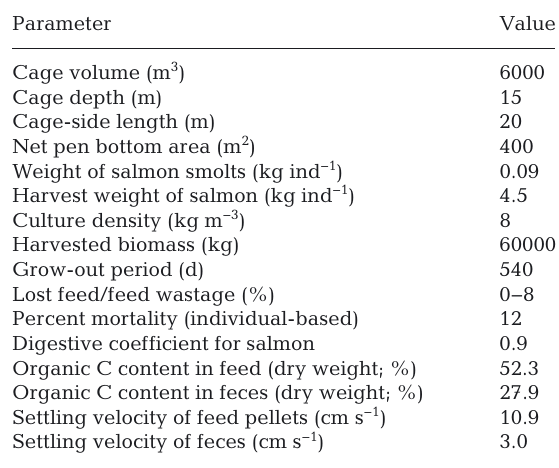
Table 1. Parameters required for estimation of wastage rate (lost feed plus feces) for a single representative salmon farming cycle based on Stucchi et al. (2005), Petersen et al. (2005), and Chang et al. (2014). Digestion coefficient represents the proportion assimilated of ingested